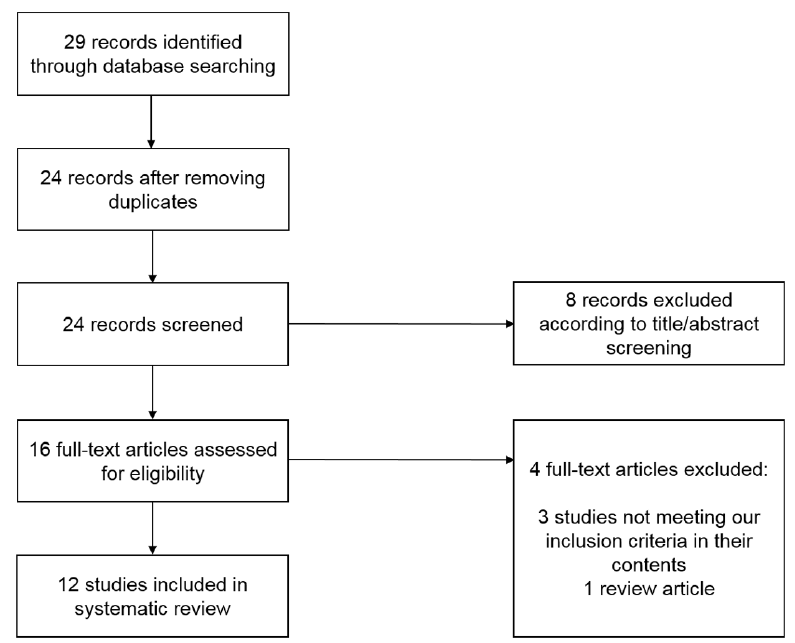
Figure 3 . Flow diagram of systematic literature search. Figure 3. Flow diagram of systematic literature